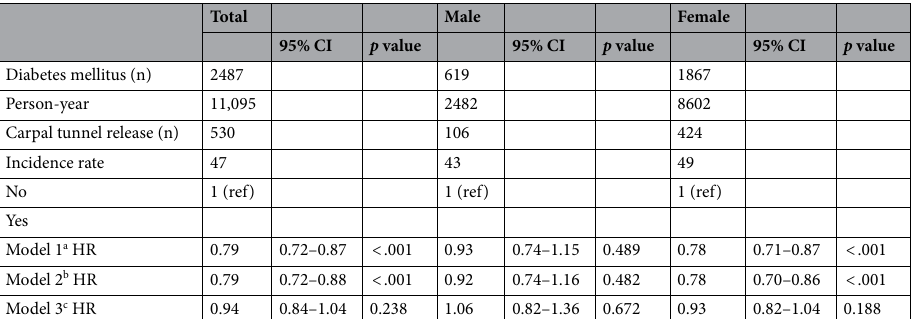
Table 3. Multivariate cox regression analysis for carpal tunnel release in participants with carpal tunnel syndrome according to DM presence. Incidence rate is the incidence of mortality per 1000 person-year. a Model 1 : unadjusted. b Model 2: adjusted for age and socioeconomic status (residential area, income level, and insurance type). c Model 3: adjusted for age, socioeconomic status (residential area, income level, and insurance type), and co-morbidities (CCI, hypertension, hypothyroidism, rheumatoid